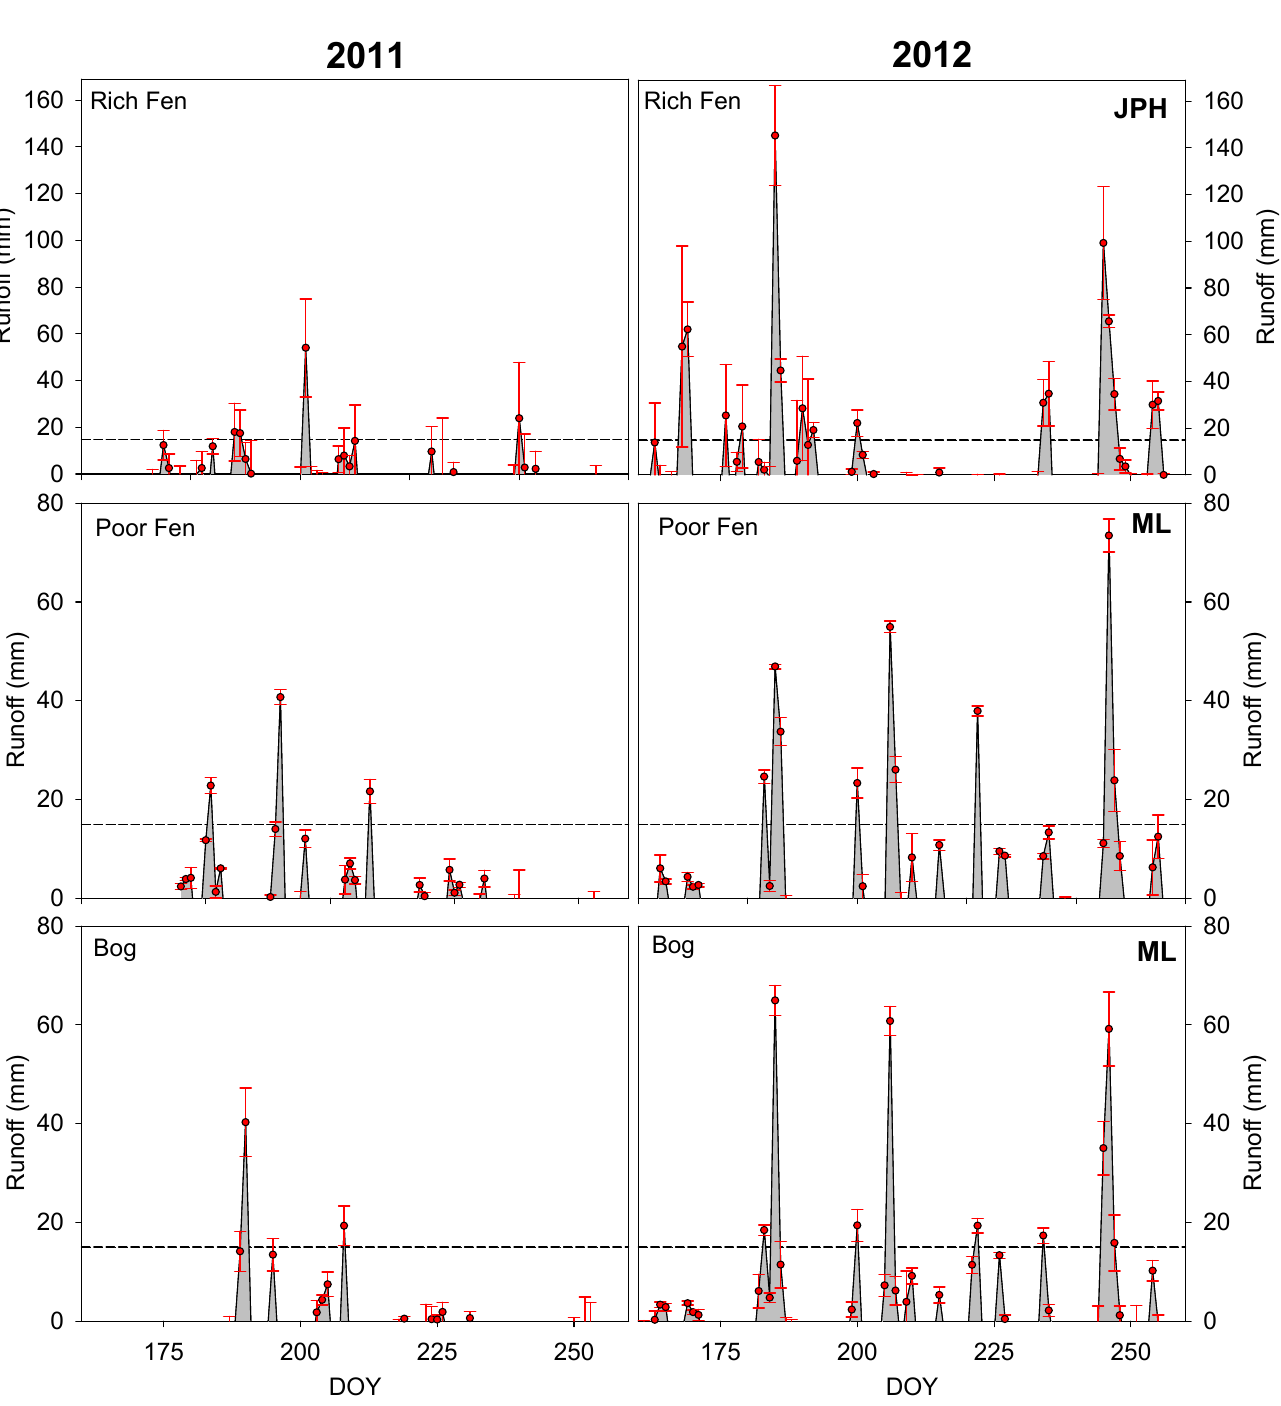
Figure 4. Time series of 2011 and 2012 runoff potential as estimated by vertical water balance for selected terrain units at ML and JPH sites. Red points denote individual daily values, error bars show 1 standard deviation of uncertainty. Dashed lines indicate detention storage capacity thresholds estimated from LiDAR surveys.